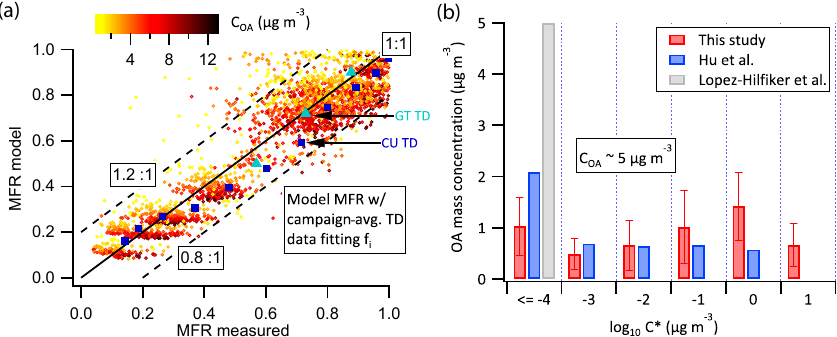
Figure 4. (a) Comparison of individual observations from the Centreville campaign and corresponding modeled MFRs applying the extracted f i distribution from the campaign-average fit ( r 2 = 0 . 83; RMSE: 0.11). MFR data collected by other groups during the Centreville campaign are also shown: University of Colorado TD (CU TD, blue squares) (Hu et al., 2016) and Georgia-Tech TD (GT TD, cyan triangles) (Cerully et al., 2015), along with corresponding MFRs modeled applying volatility parameterizations from this study with the campaign-average C OA and d p . Figure S9 shows an extended data figure of panel (a) , including a similar plot using the f i distribution from the unified fit and analysis results for the Raleigh dataset. (b) Comparison of the SOAS campaign-average OA volatility distribution (showing only condensed phase) derived from this study (dual TDs, kinetic evaporation model fits), Hu et al. (2016) (TD; method of Faulhaber et al., 2009), and Lopez-Hilfiker et al. (2016) (FIGAERO-CIMS). Error bars on data from this study are ± 1 standard deviation of distributions extracted over the campaign period (Fig.